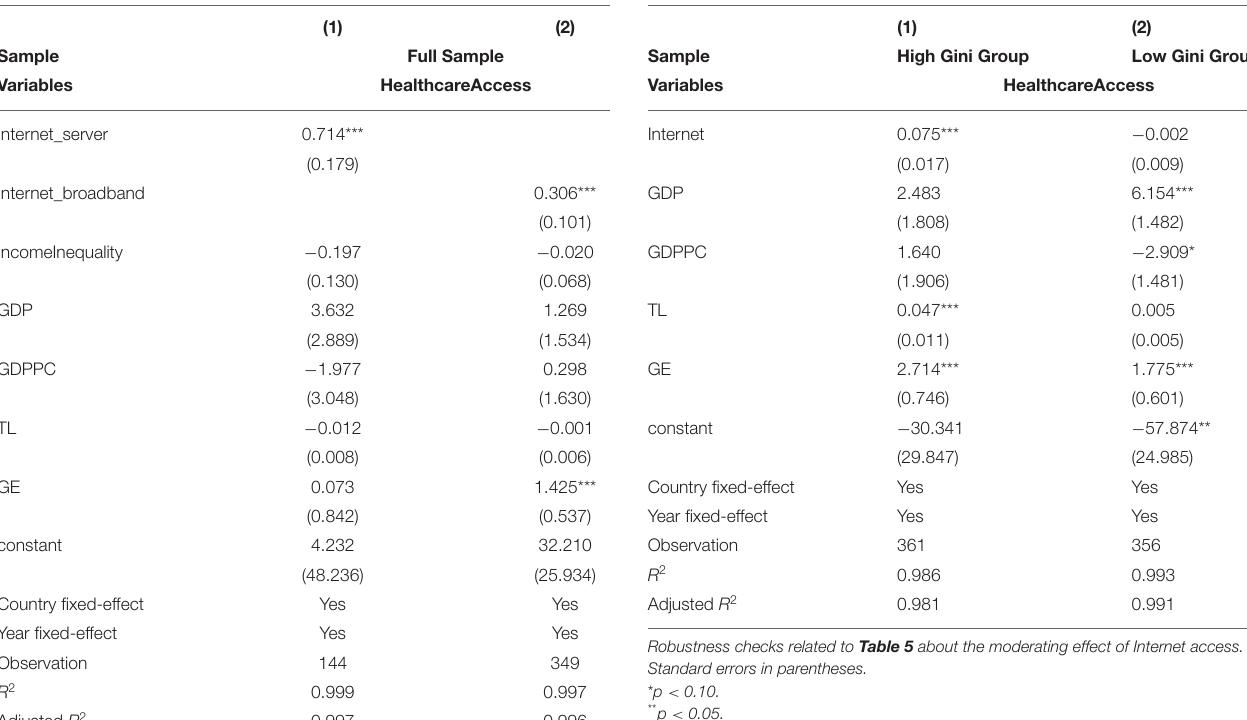
TABLE 9 | Robustness checks using alternative measures. TABLE 10 | Robustness checks using